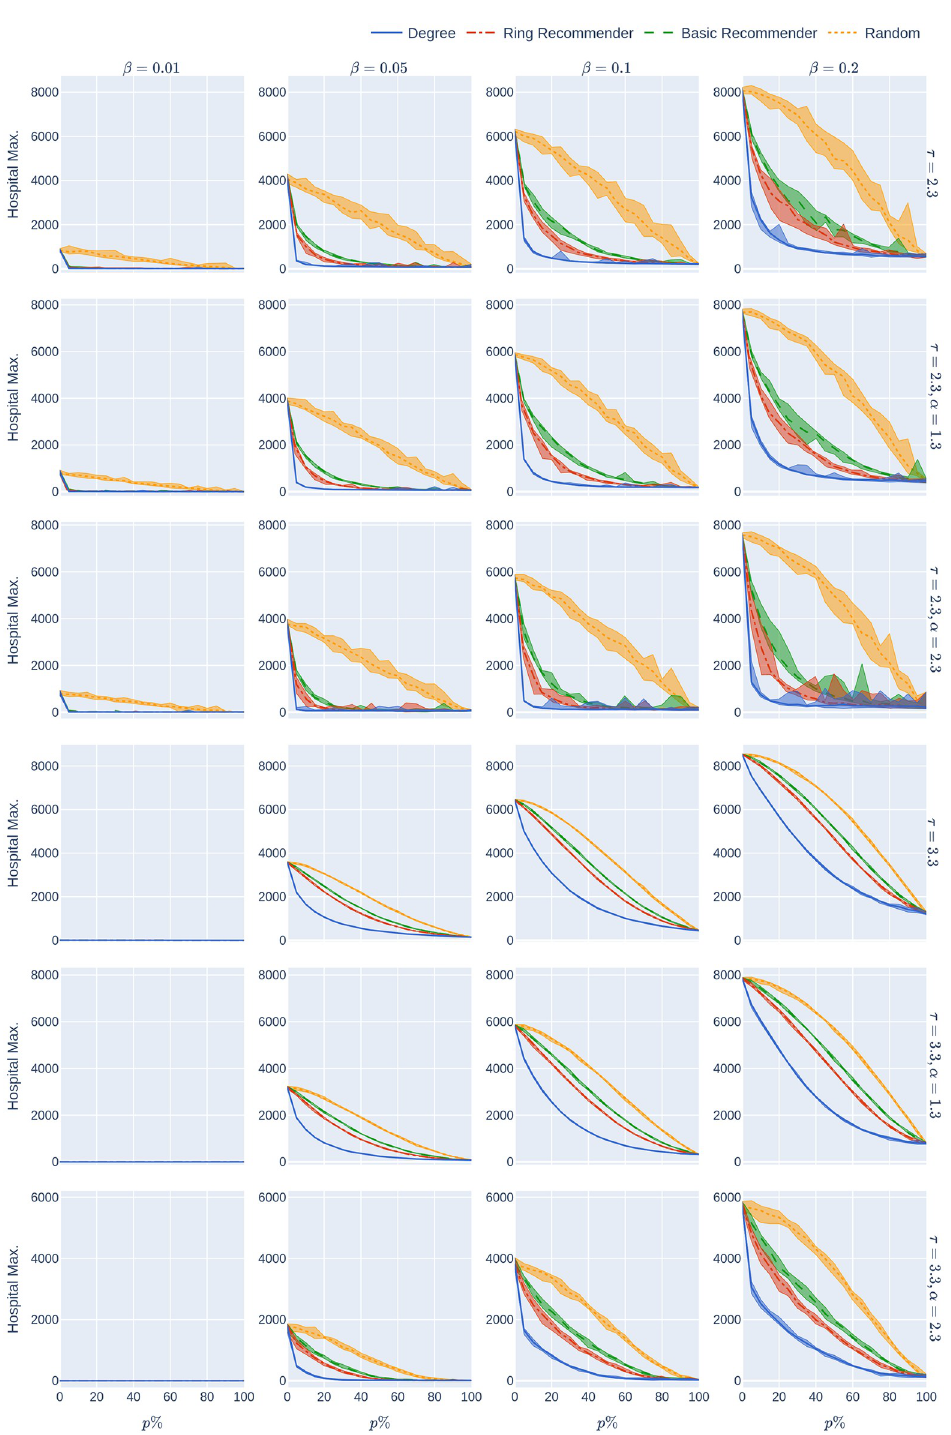
Fig 4. The maximum hospital load as a function of the uptake percentage p %. The population is modelled using four 500,000-node GIRG networks where τ = 2.3 has more super-spreaders and τ = 3.3 has fewer super-spreaders, α = 1.3 is less geometric and α = 2.3 is more geometric, arranged in the four rows. For comparison, there are two rows for 500,000-node configuration models with τ = 2.3 and τ = 3.3. The x -axis shows the uptake percentage p % varying from 0 to 100% at step size 5%. Simulations are done for the 21 values of p % corresponding to these steps. The y -axis shows the corresponding value Hmax( p ). Different columns indicate varying infection probabilities β . The HMax data in